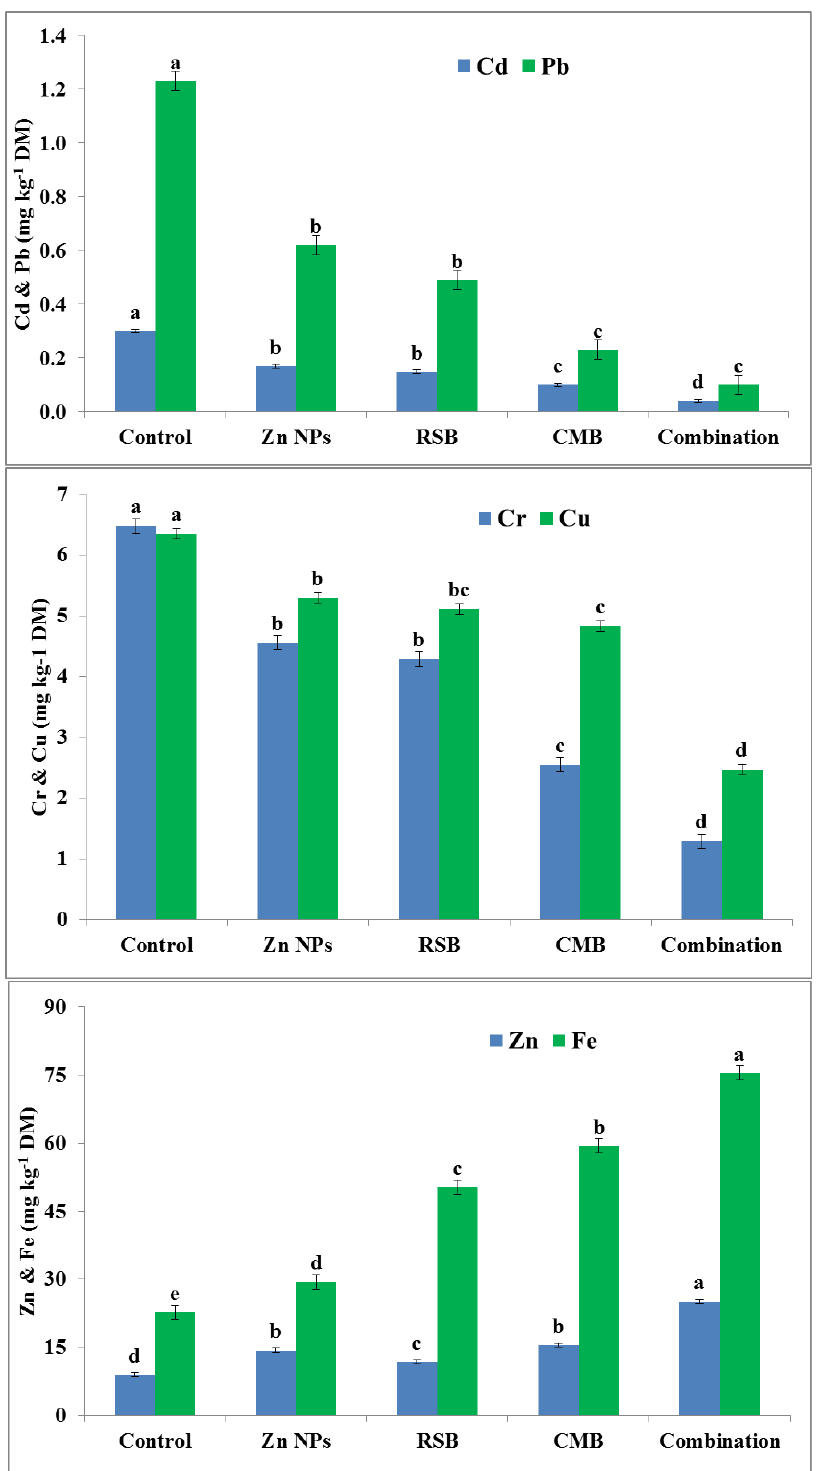
Figure 2. Effect of zinc nanoparticles and biochar of rice-straw and cow-manure on heavy metals accumulation in biomass of sunflowers grown in soil irrigated with wastewater over a long-term period (Data are the combined statistical analysis over the two seasons). Zn NPs = Zinc nano-particles, RSB = Rice straw biochar, CMB = Cow manure biochar, DM = dry matter, Error bars = Standard error of means (SEM). Means with di ff erent superscripts a–e for the same color of columns are significantly di ff erent at probability ( p ) ≤